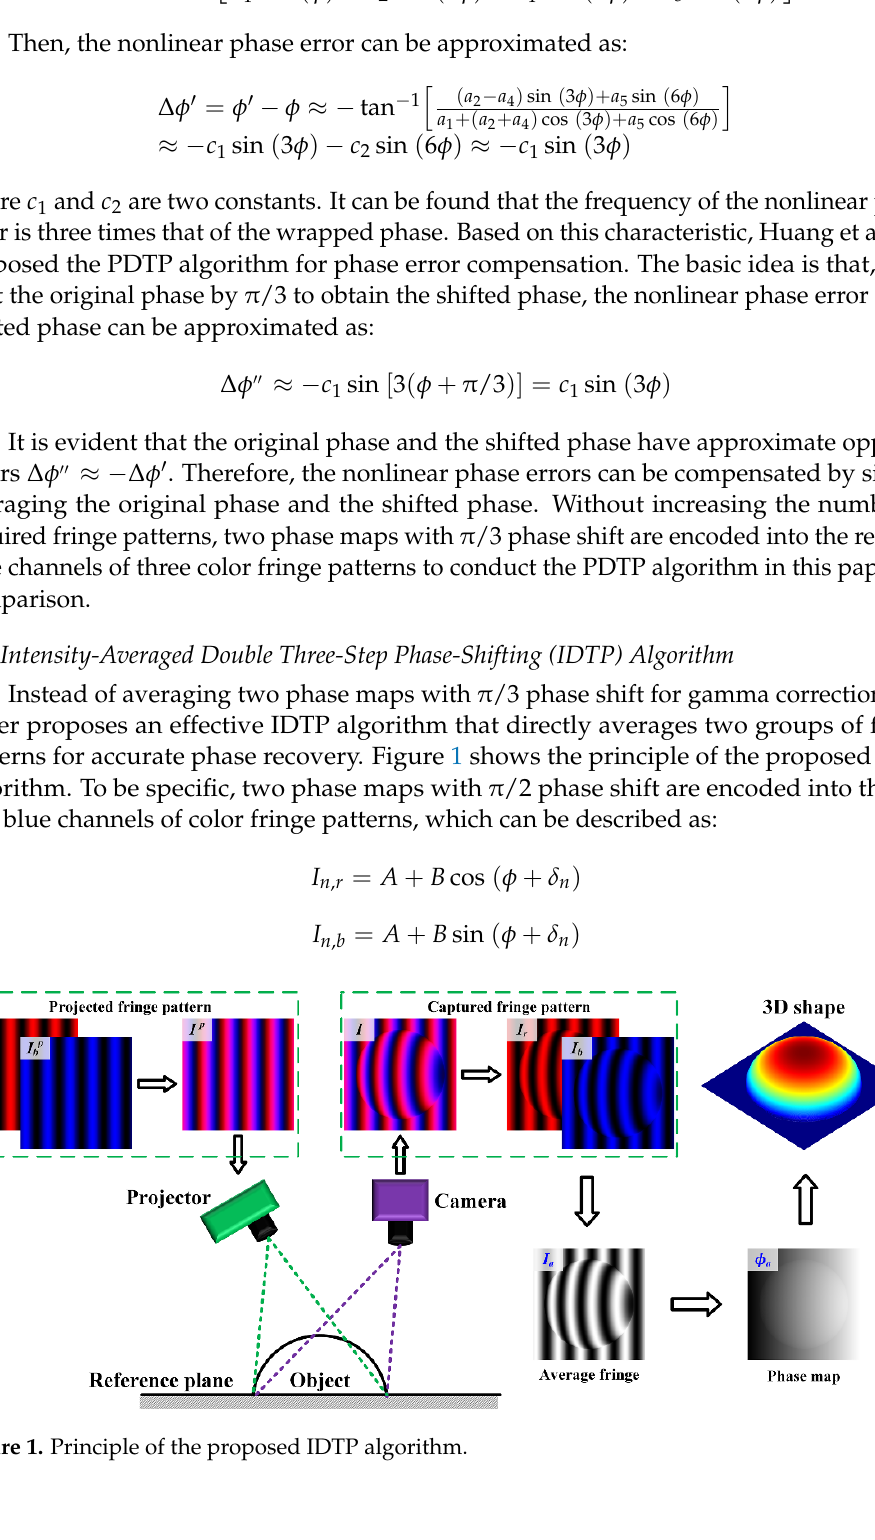
(14) Figure 2. ( a , b ) The red and blue channels of the distorted fringe patterns when the gamma value is set to